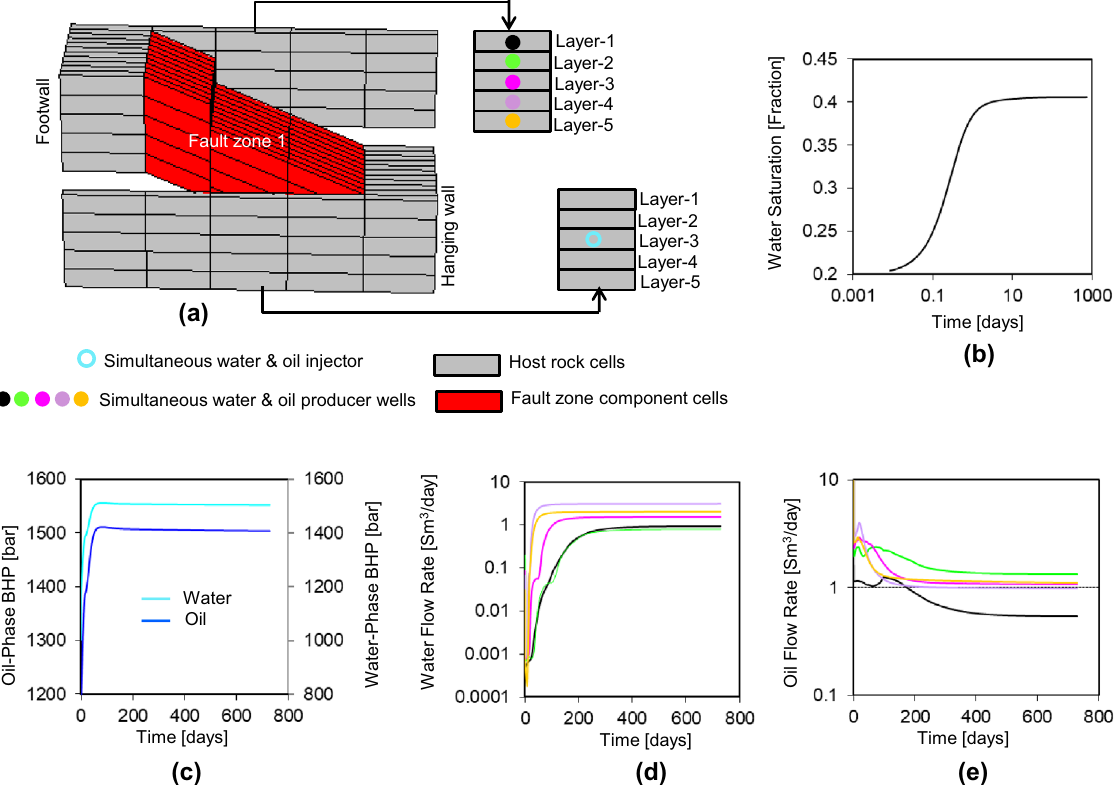
Figure 11. ( a ) As Fig. 9a, but showing the wells in the same colors as used in the remainder of the figure which shows simulation results for injection with a 40% fractional water flow. ( b ) Water saturation. ( c ) Oil- and water- phase injection well bottom-hole pressure. ( d ) Water and ( e ) oil flow rates. Note that the producer wells and associated data are not shown in the cells in layers 1, 2, 4 and 5 of the hanging wall, as flow rates into these wells were below the resolution of the